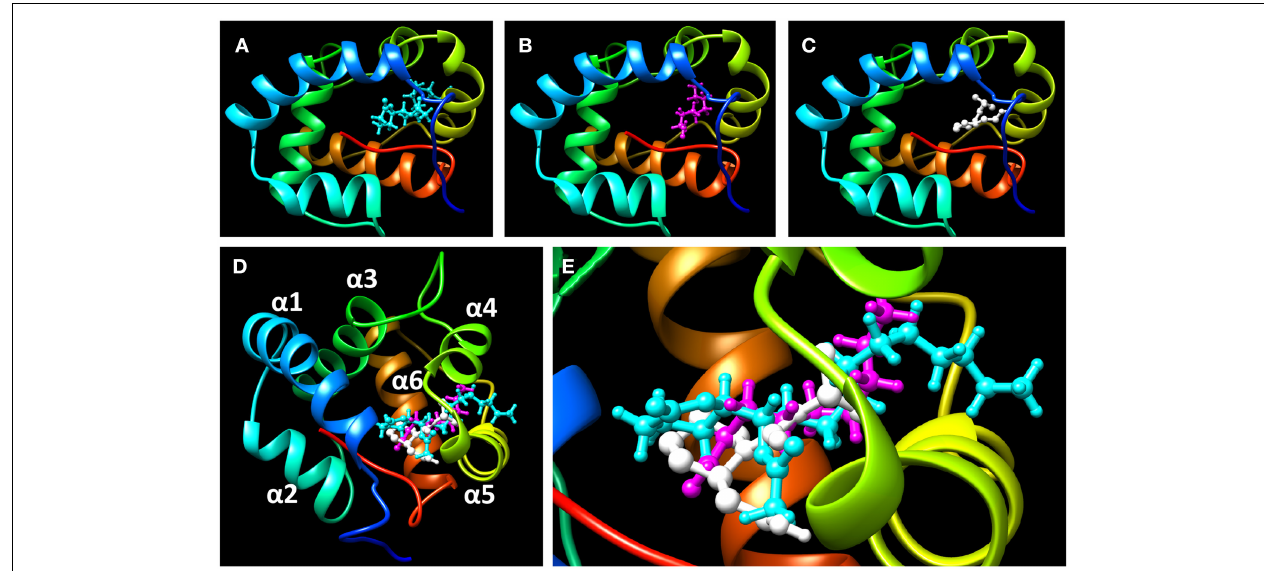
FIGURE 5 | Highlights of the ligands docked in the binding cavity of CquiOBP1. (A) MOP, (B) nonanal, and (C) picaridin. Note that snapshots from (A–C) have the same OBP orientation. (D) the three docked ligands are overlapped: MOP (cyan), nonanal (magenta), and picaridin (white). Note that MOP polar head (lactone/acetate moiety) is housed in the central binding